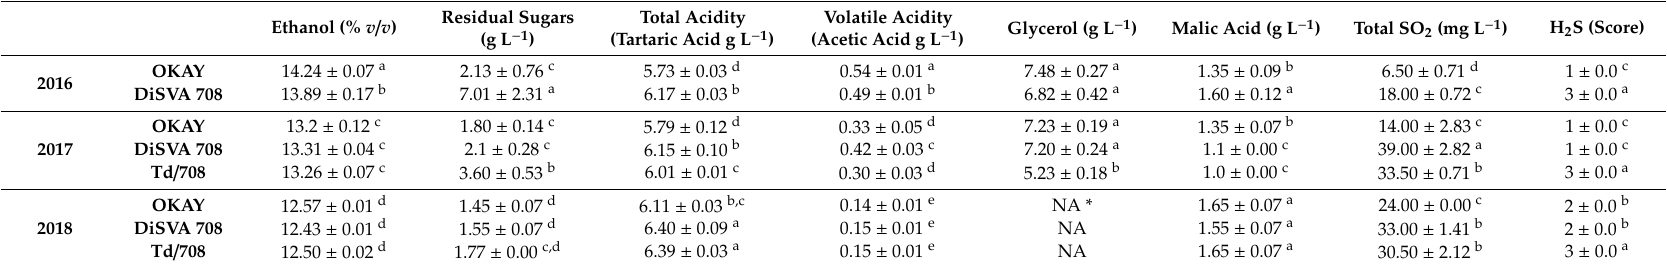
Table 2. Main analytical parameters of the wines obtained across the vintages 2016–2018. Data are means ± standard deviations. Values displaying di ff erent superscript letters ( a,b,c,d,e ) within each column are significantly di ff erent according to Duncan tests ( p < 0.05). The abbreviations Td / 708 indicate the sequential fermentations carried out by T. delbrueckii / S. cerevisiae DiSVA 708.